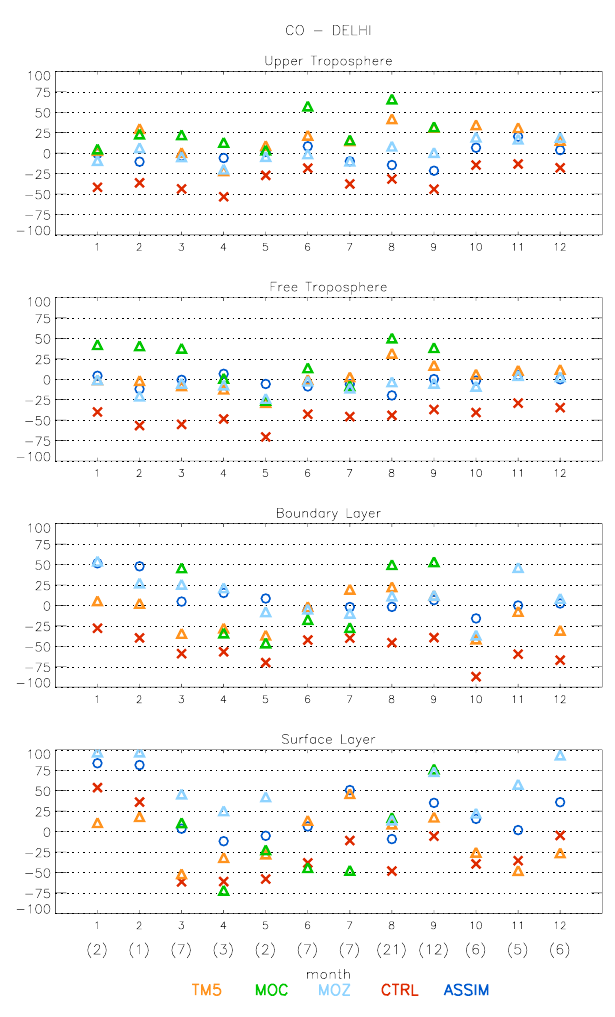
Fig. 7. Same as Fig. 5 except over